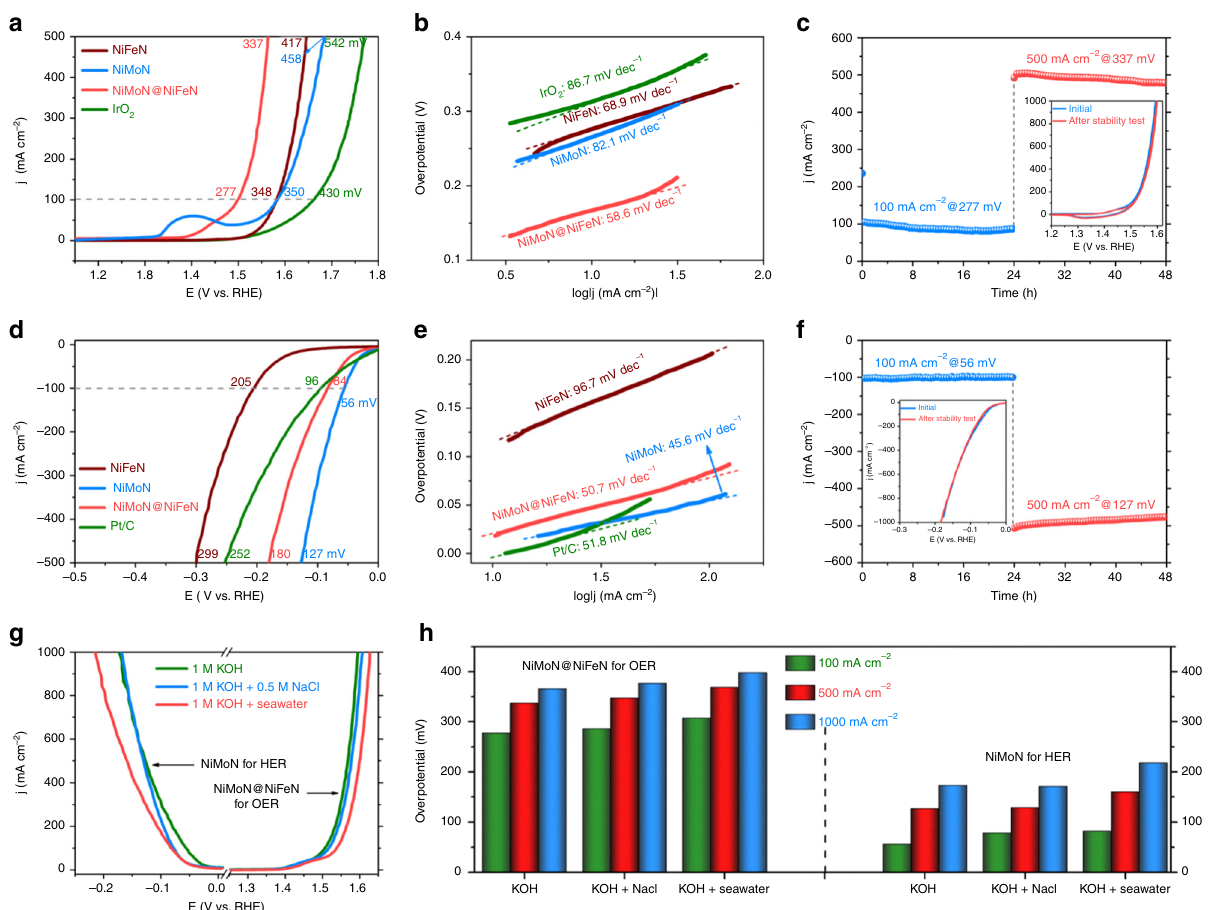
Fig. 3 Oxygen and hydrogen evolution catalysis. a OER polarization curves in 1 M KOH, and b corresponding Tafel plots of different catalysts. c OER chronoamperometry curves of NiMoN@NiFeN at overpotentials of 277 and 337 mV in 1 M KOH. Inset: CV curves of NiMoN@NiFeN before and after the stability test. d HER polarization curves tested in 1 M KOH, and e corresponding Tafel plots of different catalysts. f HER chronoamperometry curves of NiMoN at overpotentials of 56 and 127 mV in 1 M KOH. Inset: LSV curves of NiMoN before and after the stability test. g OER and HER polarization curves of NiMoN@NiFeN and NiMoN, respectively, in different electrolytes. h Comparison of the overpotentials required to achieve current densities of 100, 500, and 1000 mA cm − 2 for NiMoN@NiFeN (OER) and NiMoN (HER) in different SEM images after OER stability tests (Supplementary Fig. 11)